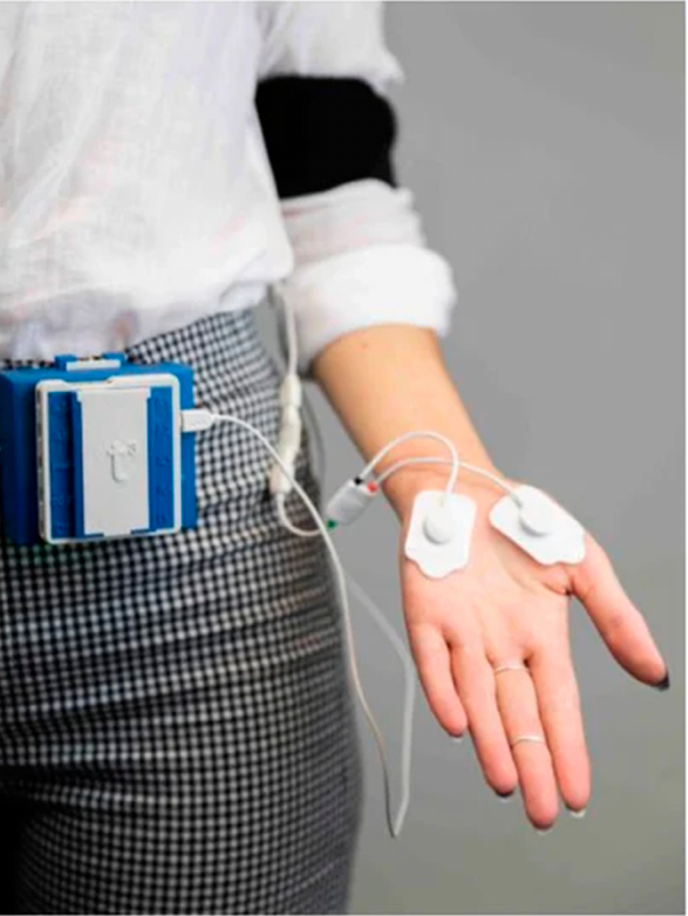
Figure 3. The electrodes placed on the participant’s non-dominant hand are connected to sensor cables wired to the COBALT Bluebox device. Image source: Brissette-Gendron, R., L é ger, P.M., Courtemanche, F., Chen, S.L., Ouhnana, M., and S é n é cal, S. (2021). The response to impactful interactivity on spectators’ engagement in a digital game. Multimodal Technologies and Interaction, 4(89), 89–89. https://doi.org/10.3390/mti4040089, accessed on 20 December